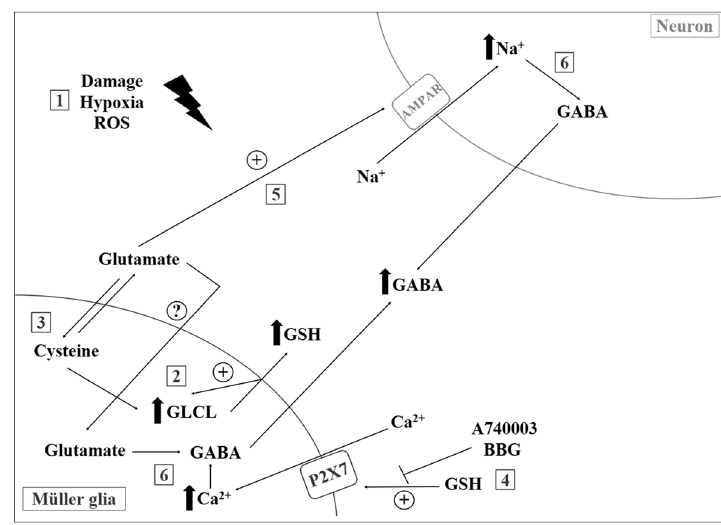
Figure 1. Mechanisms of functional compartmentalization mediated by glutathione in the retinal environment. Tissue damage, hypoxia, and reactive oxygen species (ROS) (1) promote increased activity of antioxidant system intermediates in Müller glial cells, such as γ -glutamylcysteine ligase (GLCL), which stimulates the synthesis/release of glutathione (GSH) (2) and the uptake of cysteine through a glutamate-cysteine antiporter system (3) When released, GSH is capable of activating P2X7 receptors, allowing for intense Ca 2+ increase in the Müller cells (4) while extracellular glutamate promotes activation of AMPA receptors ( α -amino-3-hydroxy-5-methyl-4-isoxazolepropionic acid receptors, or AMPAR) in retinal neurons, leading to higher Na + levels in these cells (5) Finally, intracellular Ca 2+ (glia) and Na + (neurons) stimulate GABA (gamma-aminobutyric acid) release to the extracellular environment (6). (+) Activation/stimulus. (?) Unknown mechanism.